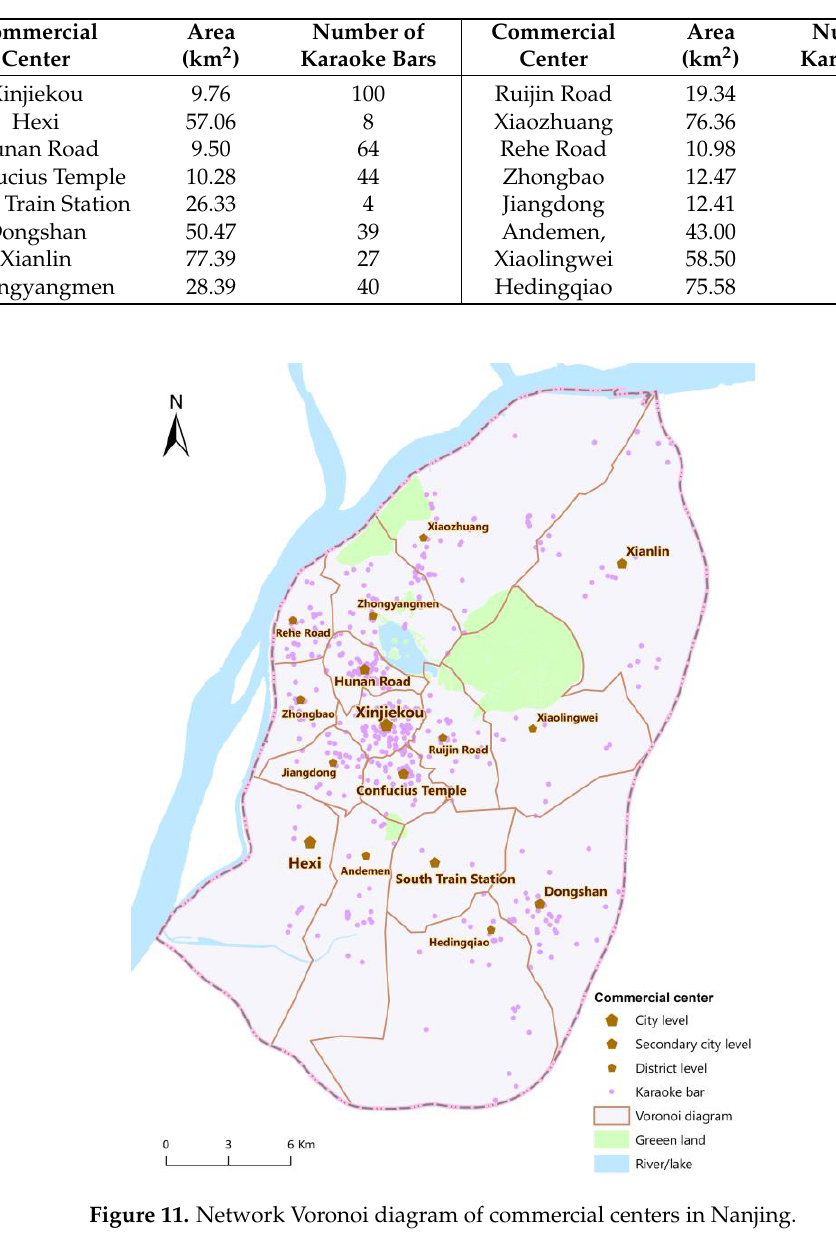
Table 4. Statistics of karaoke bars in each Voronoi diagram of the commercial centers.